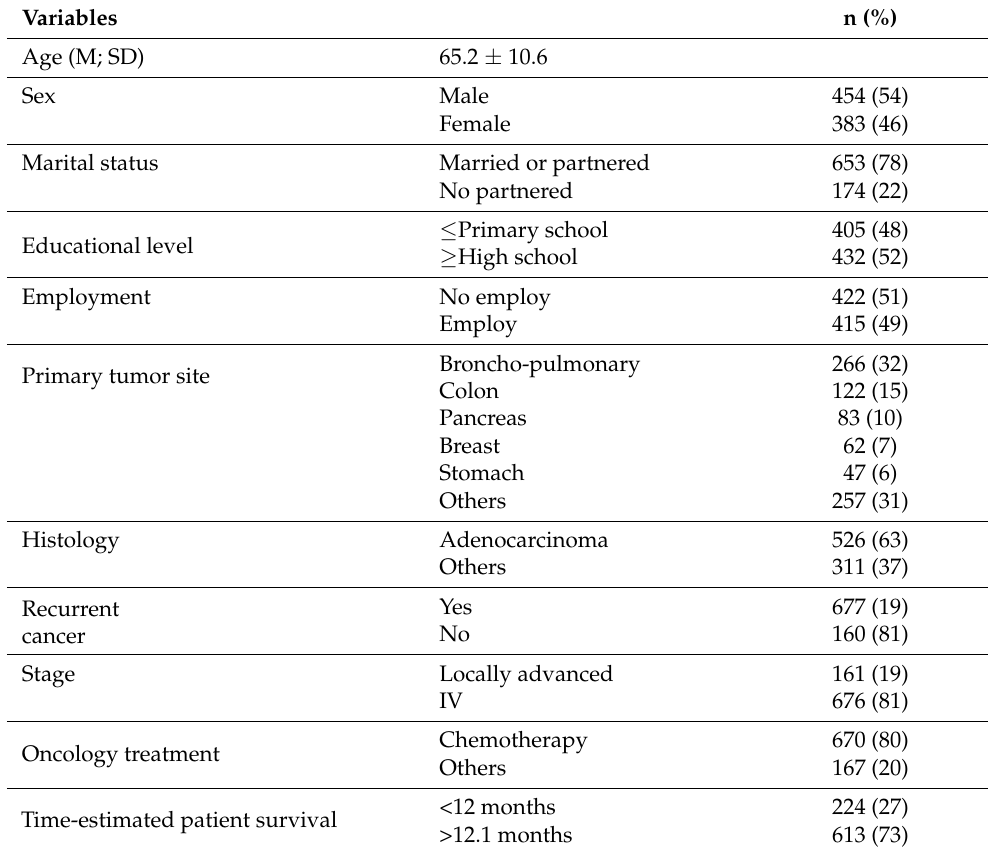
Table 1. Baseline characteristics (n =